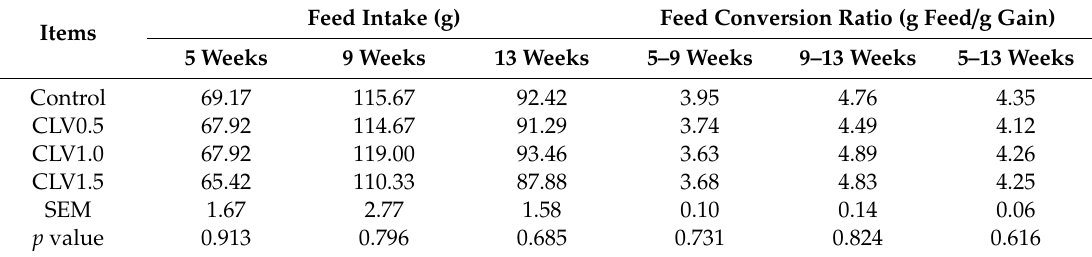
Table 3. Feed intake and feed conversion ratio of growing NZW rabbits as a ff ected by dietary treatments at 13 weeks of age.